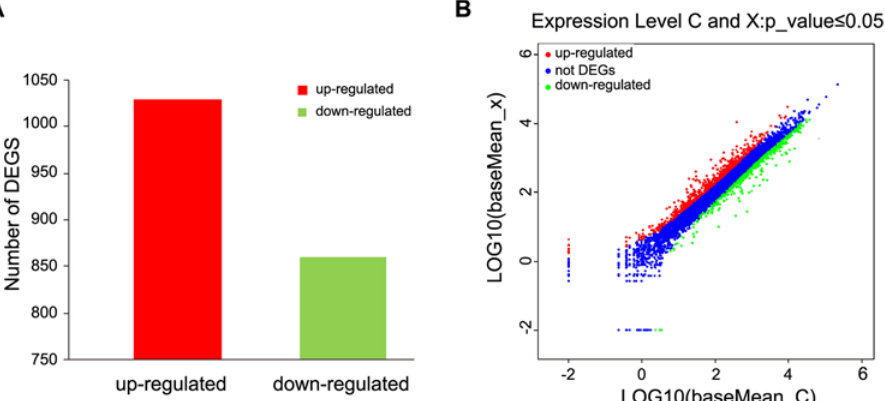
Fig 1. Differentially-expressed gene (DEGs) in different groups ( P (cid:3) 0 . 05 ). A. Totally 1890 differentially expressed genes were detected, of which 1030 were up-regulated and 860 were down-regulated ( P (cid:3) 0 . 05 ). B. Differentially expressed genes. The red part represents the up-regulated genes in berberine hydrochloride-treated group compared to control group. The green part indicates the down-regulated genes in berberine hydrochloride-treated group. The blue part shows the genes without expression difference between these two